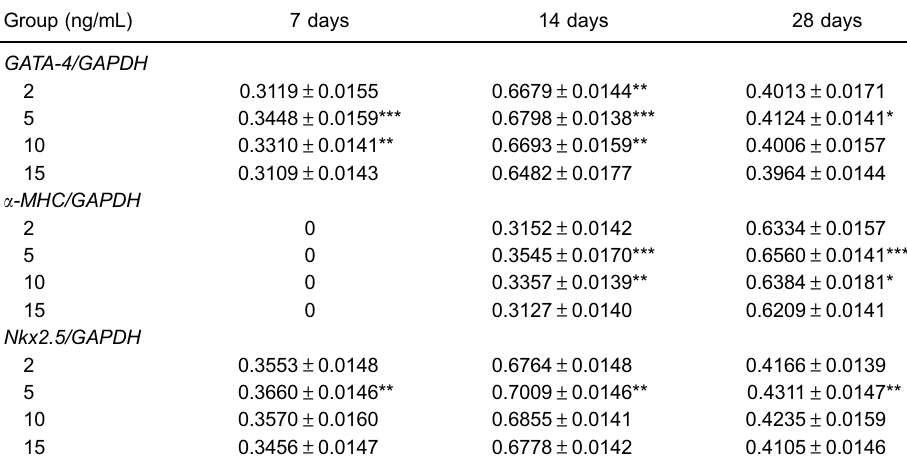
Table 2. mRNA expression for GATA-4 , Nkx2.5 , a -MHC in bone mesenchymal stem cells (MSCs) treated with different concentrations (ng/mL) of TGF- b 1. Group (ng/mL)